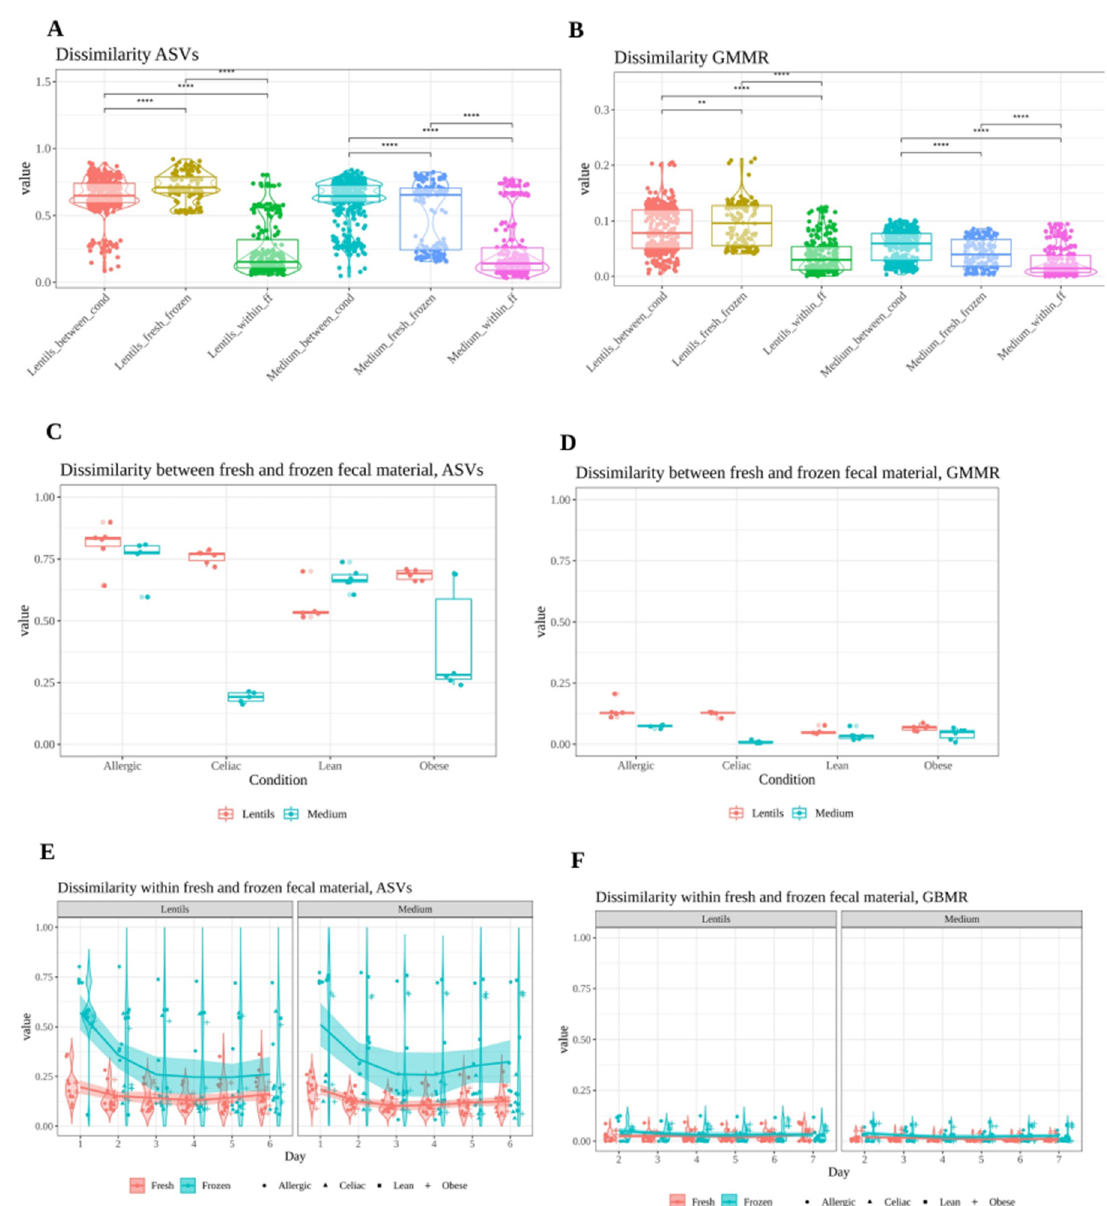
Figure 3. Bray–Curtis (ASVs) and Jaccard (GMMR) dissimilarity values. ( A , B ) show overall dissimilarity values in the three different situations tested for ASVs and GMMR for all days of the experiment considered together; ( C , D ) show dissimilarity values between fresh and frozen fecal material. Comparisons were made for each condition: day 1 fresh vs. day 1 frozen; day 2 fresh vs. day 2 frozen; day 3 fresh vs. day 3 frozen; day 4 fresh vs. day 4 frozen; day 5 fresh vs. day 5 frozen; day 6 fresh vs. day 6 frozen; ( E , F ) show dissimilarity values between stabilization and in vitro fermentation days. Here, each day is compared to the rest. Statistical labels: ** p < 0.01; **** p < 0.0001.